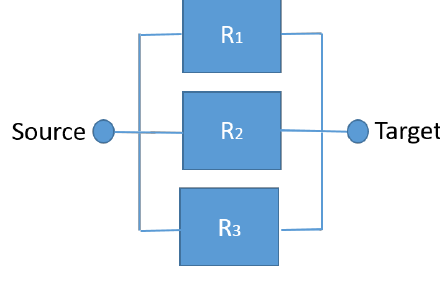
Figure 6. RBD organized in